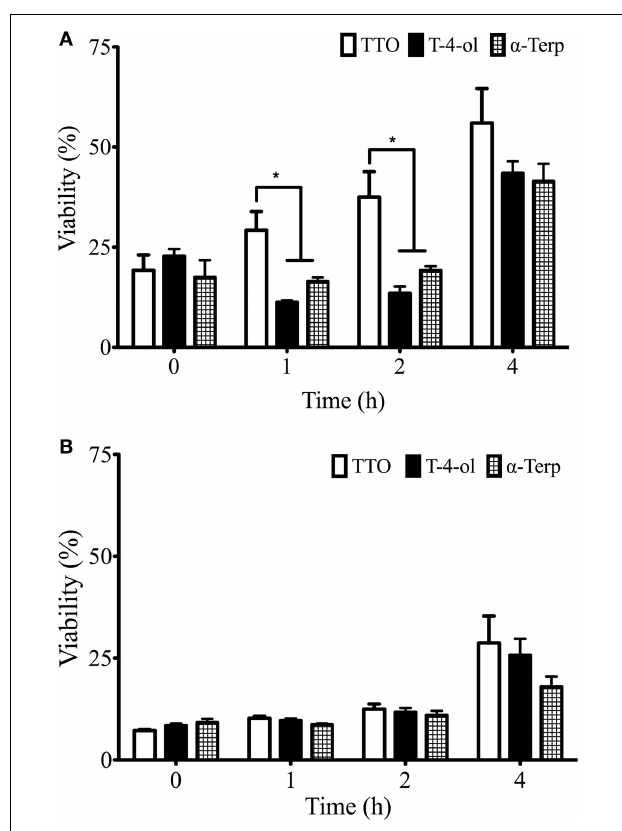
FIGURE 2 | Candida albicans biofilm development is inhibited byTTO, T-4-ol, and α -terpineol. Standardized C. albicans (1 × 10 6 cells/ml) were added to a flat-bottomed 96-well plate and treated with (A) 0.5 and (B) 1 × SMIC 50 for 0, 1, 2, and 4h post incubation. Biofilms were subsequently allowed to develop for 24h. Resultant biofilms were quantified using a crystal violet assay read at 570nm in a microtiter plate reader (FluoStar Omega, BMG Labtech). Four isolates were used for each assay, and this was performed on two independent occasions in triplicate. * p < 0.05. Error bars represent the ± standard error of the mean.